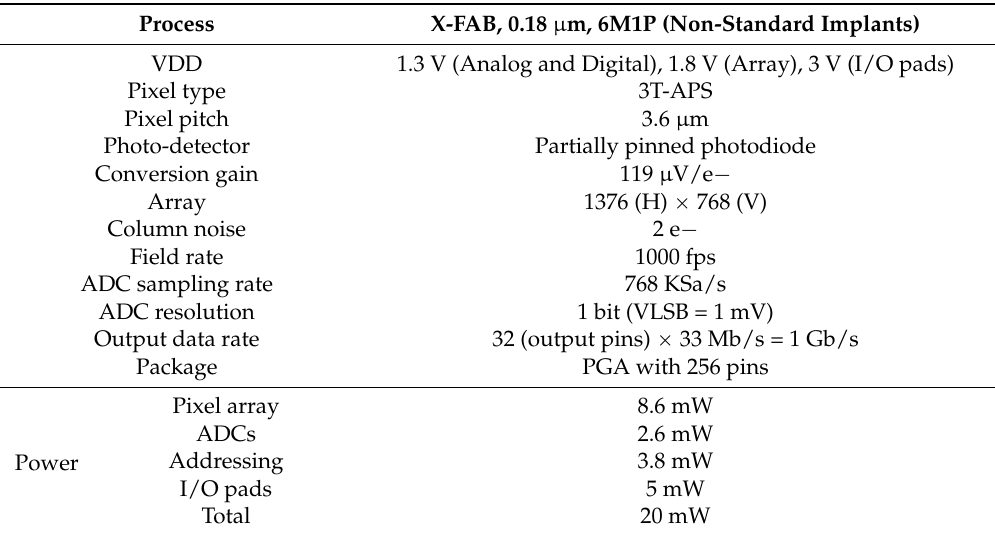
Table 2. Specifications of the 1 Mpixel binary image